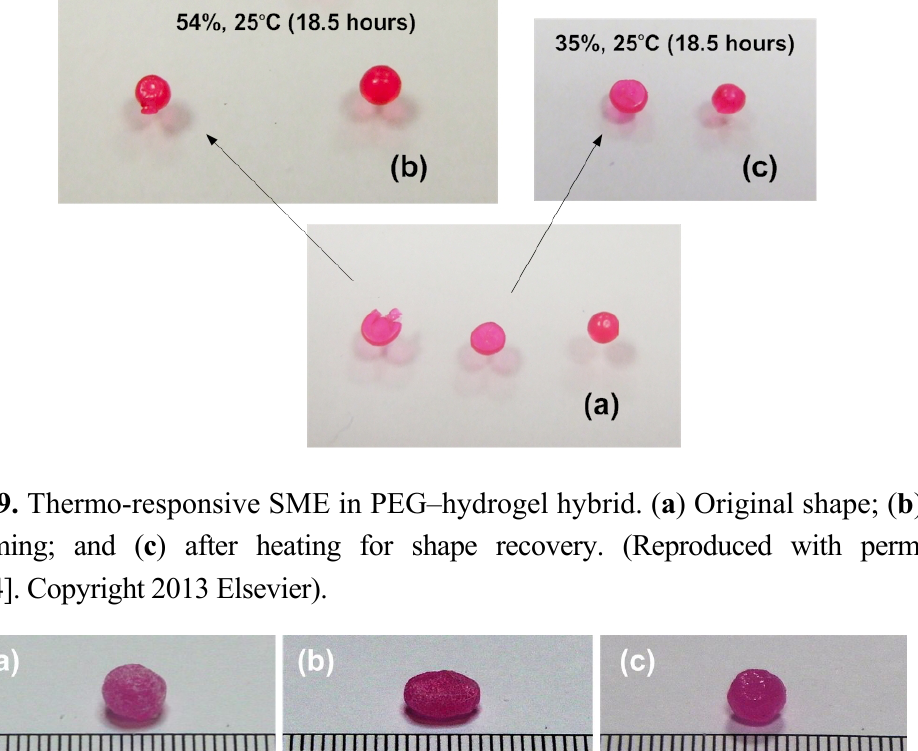
Figure 28. Moisture-responsive SME in a hydrogel. Right sample (without shape change) is for comparison. ( a ) Left two samples were compressed at high temperatures; ( b ) left sample largely recovers its original shape after 18.5 h at 25 °C and humidity 54%; and ( c ) no apparent shape change in the left sample after 18.5 h at 25 °C and humidity 35%. (Reproduced with permission from [104]. Copyright 2013 Elsevier).